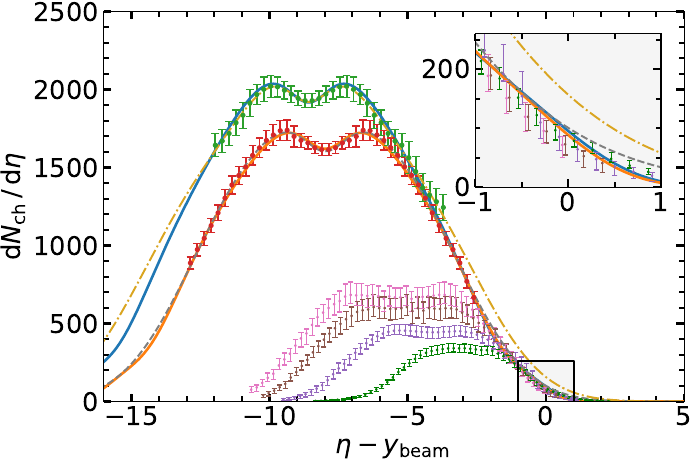
Figure 10. Comparison of the three-source RDM-distributions with linear and sinh-drift, PHOBOS data [54], and ALICE data [46,56] with emphasis on limiting fragmentation. From bottom √ √ s NN = 19.6, 62.4, 130 and 200 GeV (RHIC), Pb-Pb at s NN = 2.76 and to top: central Au-Au at 5.02 TeV. The difference between the model with sinh-drift (solid curves) and the one with linear drift (dot-dashed and dashed curves) is small, but visible in the fragmentation region. The zoom into this region shows that the RDM with sinh-drift is consistent with limiting fragmentation at Relativistic Heavy Ion Collider (RHIC) and Large Hadron Collider (LHC) energies. From Kellers and Wolschin [33], where details and parameters are